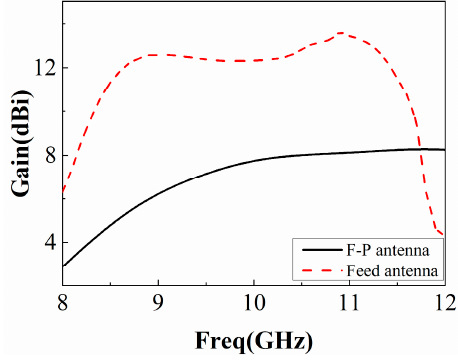
Figure 15. Gain of F-P antenna and feed antenna.